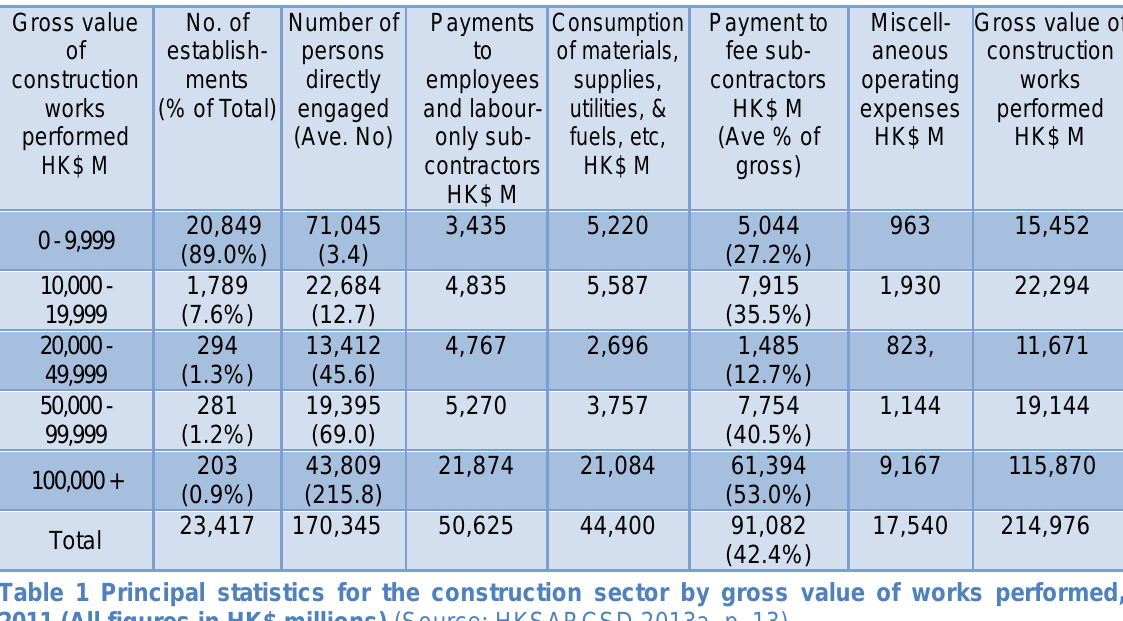
which depend on sub-contracting (Rowlinson 2007), a practice that can dissipate espoused CSR policies (Green 2007).